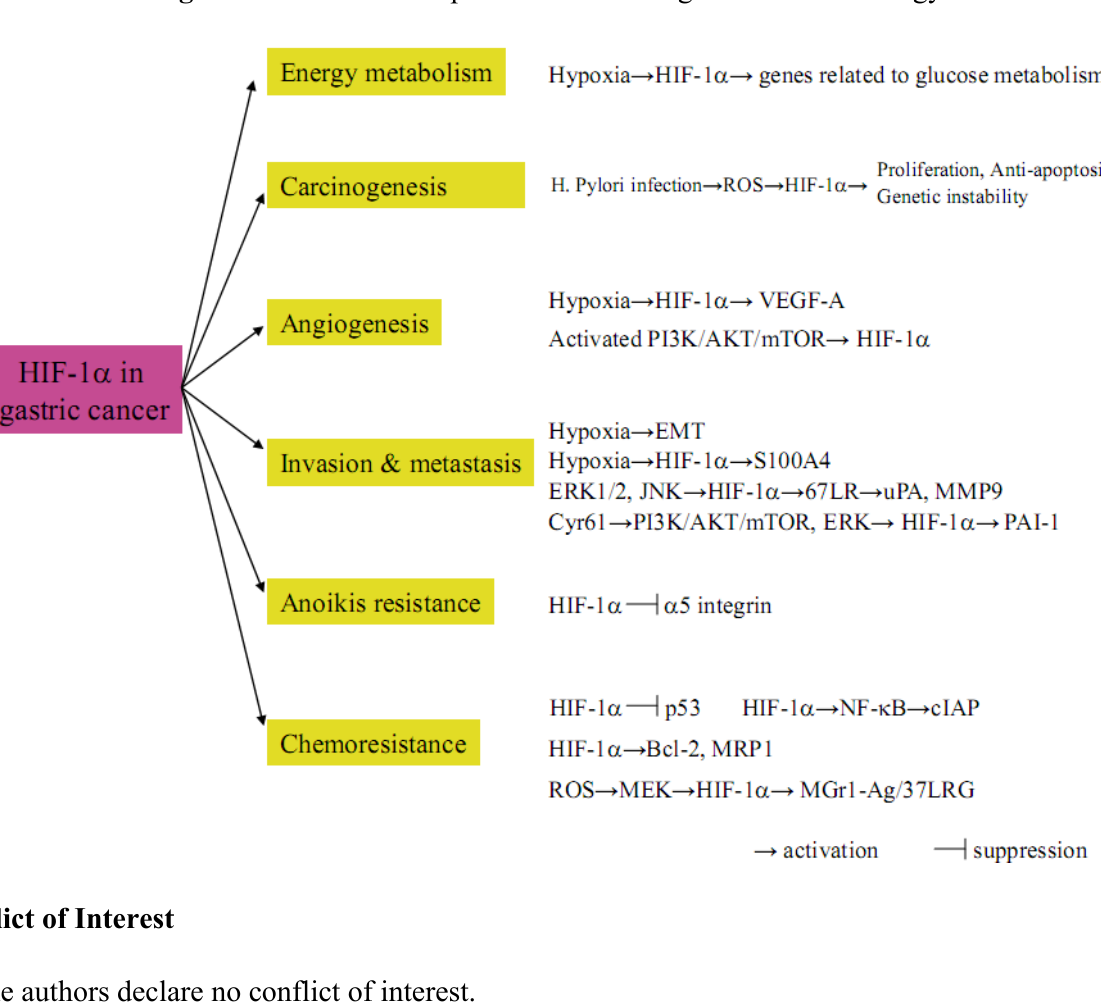
Figure 5. The critical impact of HIF-1  on gastric cancer